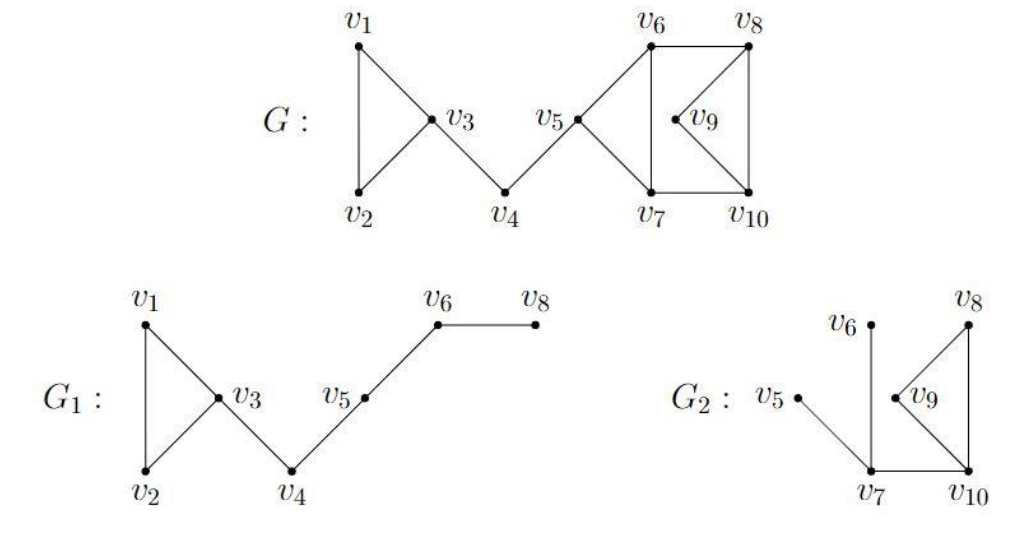
Figure 1. Graph 𝐺 and its Steiner domination decomposition 𝜋 = {𝐺 1 , 𝐺 2